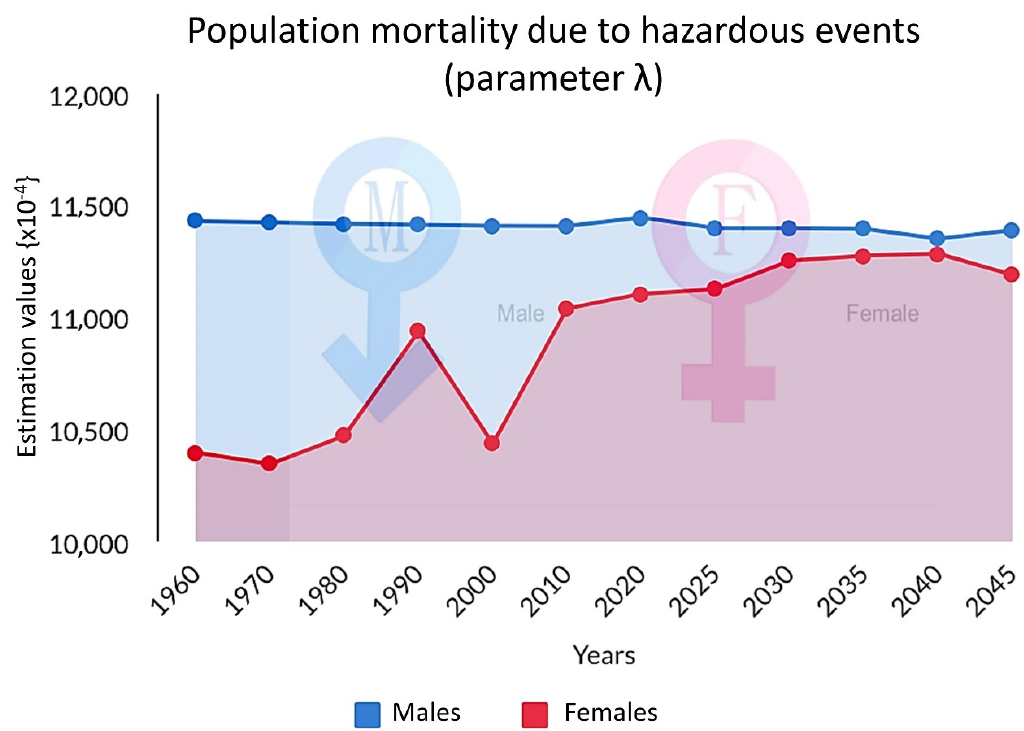
Figure 1. The evolution of collective mortality ( λ ) for the 22 EU countries in the past, present, and future, for both men (males, blue) and women (females, red), for the years from 1960 to 2045.